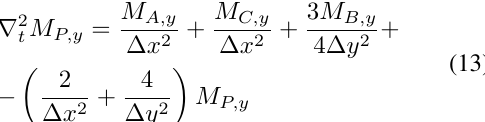
Figure 5: TE grid for a circular